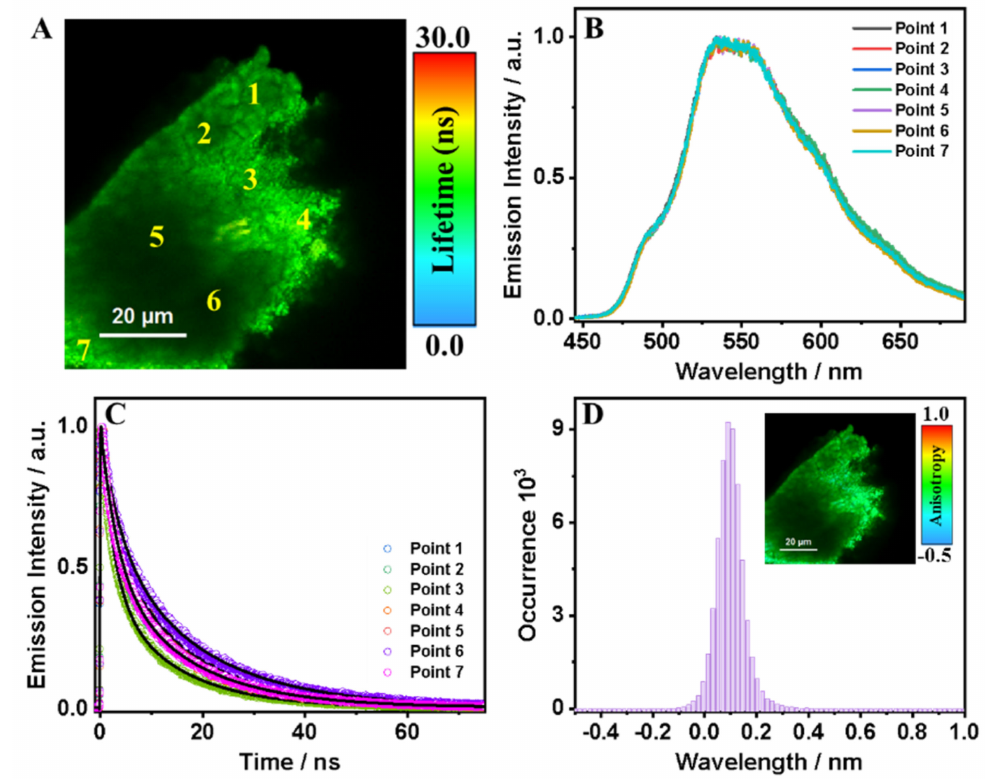
Figure 5. ( A ) FLIM image, ( B ) emission spectra, and ( C ) emission decays at different points for T12F-ester in the solid state. The solid lines are from the best fit using a multiexponential function. ( D ) Histogram of the emission anisotropy of T12F-ester in the solid state. The inset in ( D ) shows the anisotropy distribution image of the material. The excitation wavelength was 390